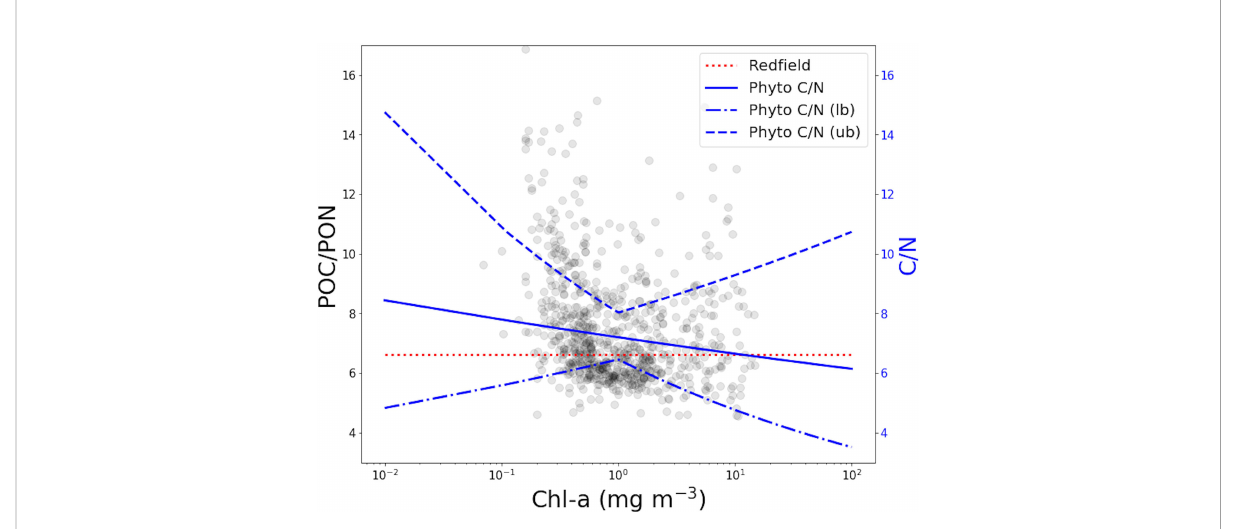
FIGURE 3 POC:PON against Chl-a showing the Red fi eld ratio (6.625, dotted red line), the phytoplankton C:N established by 1% QR regression analysis (blue line), and the relative uncertainties (upper bound, ub, dashedline line, and lower bound, lb,